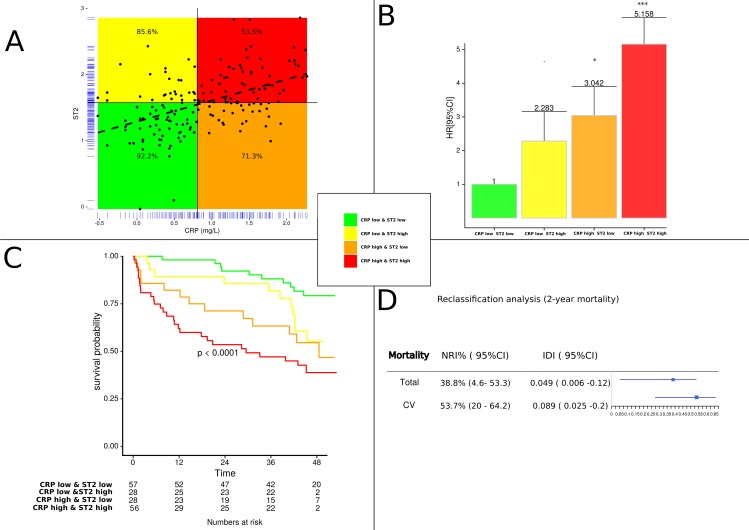
Association of ST2 with CRP levels dichotomized as high or low according to the median of each biomarker (A) Correlation analysis with survival rate in %, (B) Adjusted hazard ratio of death according to combined criteria as median of ST2 and CRP and (C) Kaplan Meier curves for all-cause mortality according to combination of median of ST2 and CRP and (D) Reclassification of two years risk of death for all cause or cardiovascular (CV) mortality. NRI and IDI values were reported when CRP was added to the clinical model in combination with high level of ST2. NRI: net reclassification index; IDI: integrated discrimination index.